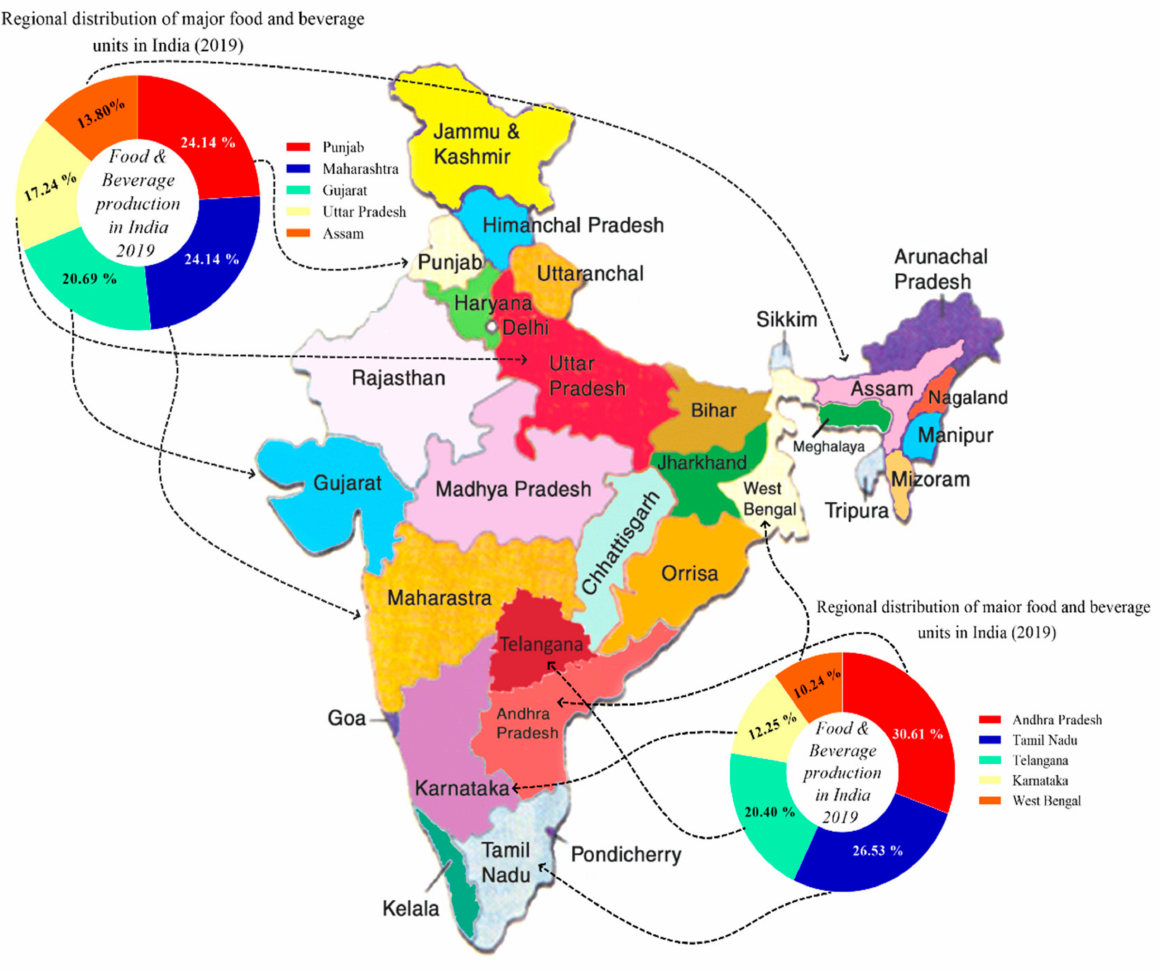
Figure 9. Regional distribution of food and beverage manufacturing industries in India.